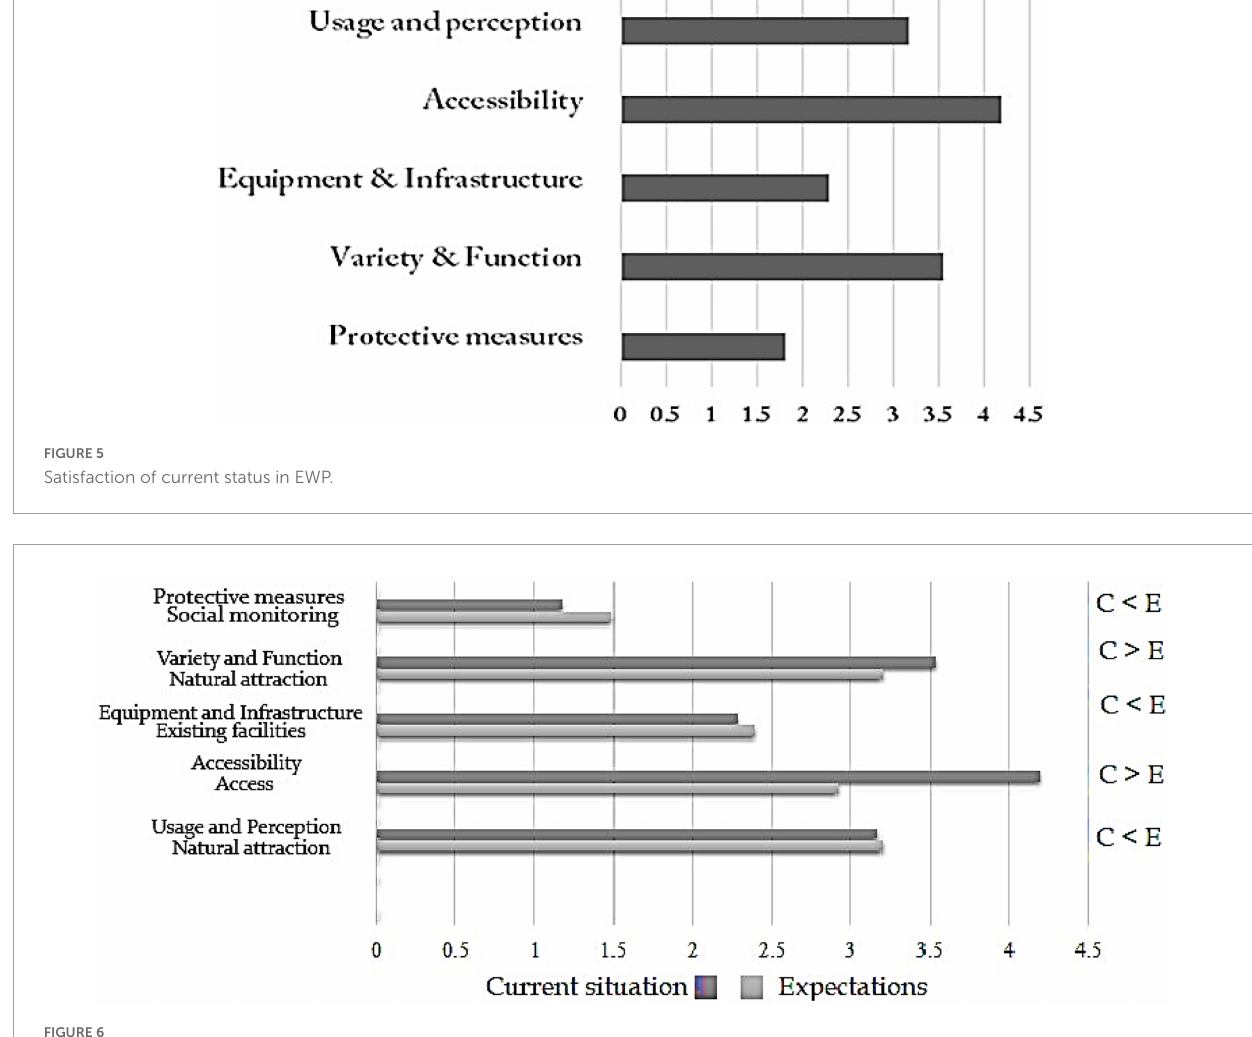
FIGURE6 Expectations of visitors vs. current conditions of